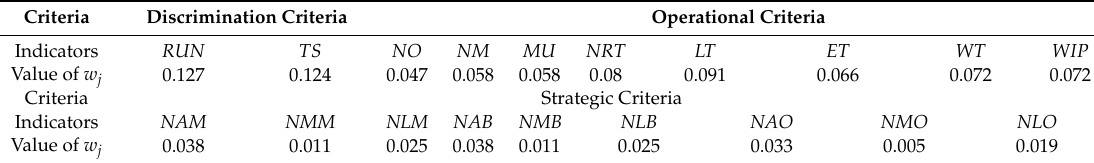
Table 10. Weights of the criteria based on the SIMOS procedure.